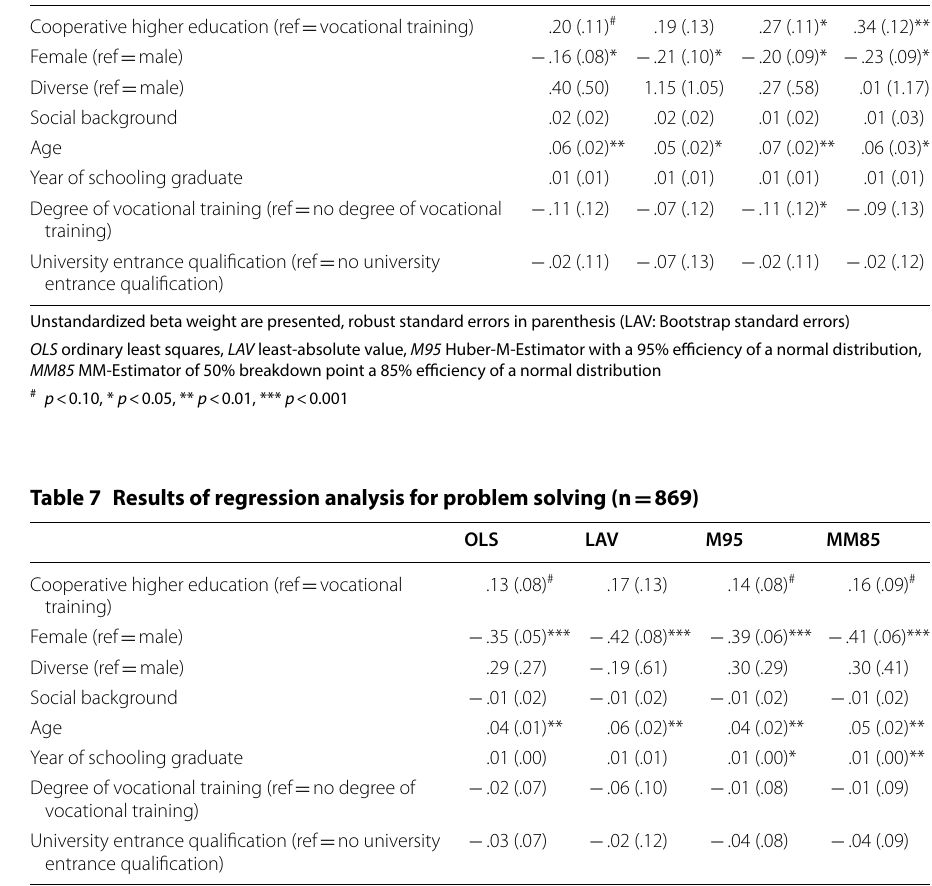
Unstandardized beta weight are presented, robust standard errors in parenthesis (LAV: Bootstrap standard errors) OLS ordinary least squares, LAV least-absolute value, M95 Huber-M-Estimator with a 95% efficiency of a normal distribution, MM85 MM-estimator of 50% breakdown point an 85% efficiency of a normal distribution # p < 0.10, * p < 0.05, ** p < 0.01, *** p <